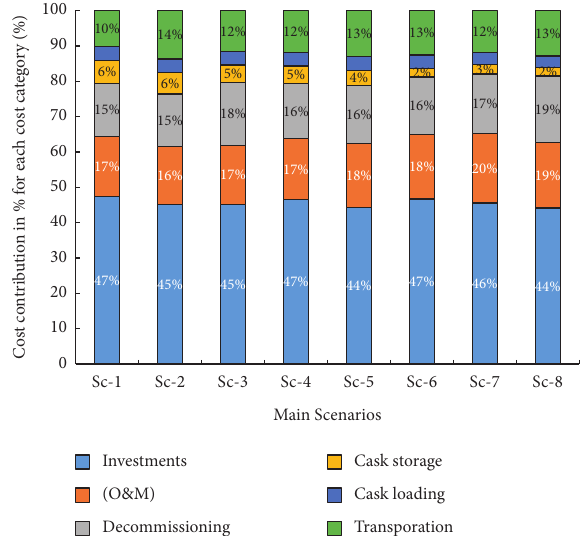
Figure 14: Cost contribution per cost category in % of total cost for each scenario.